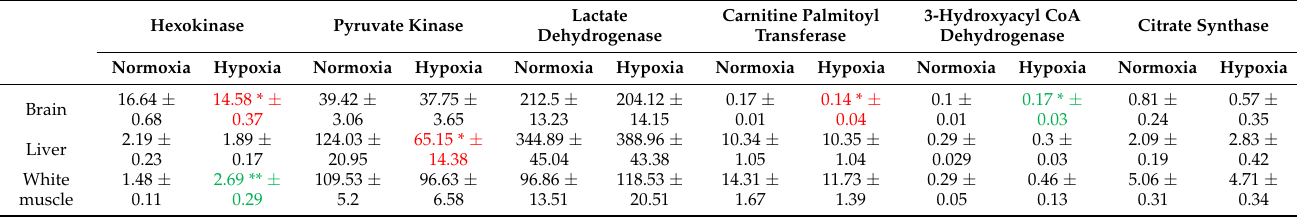
enzyme activity: green for activation and red for inhibition.